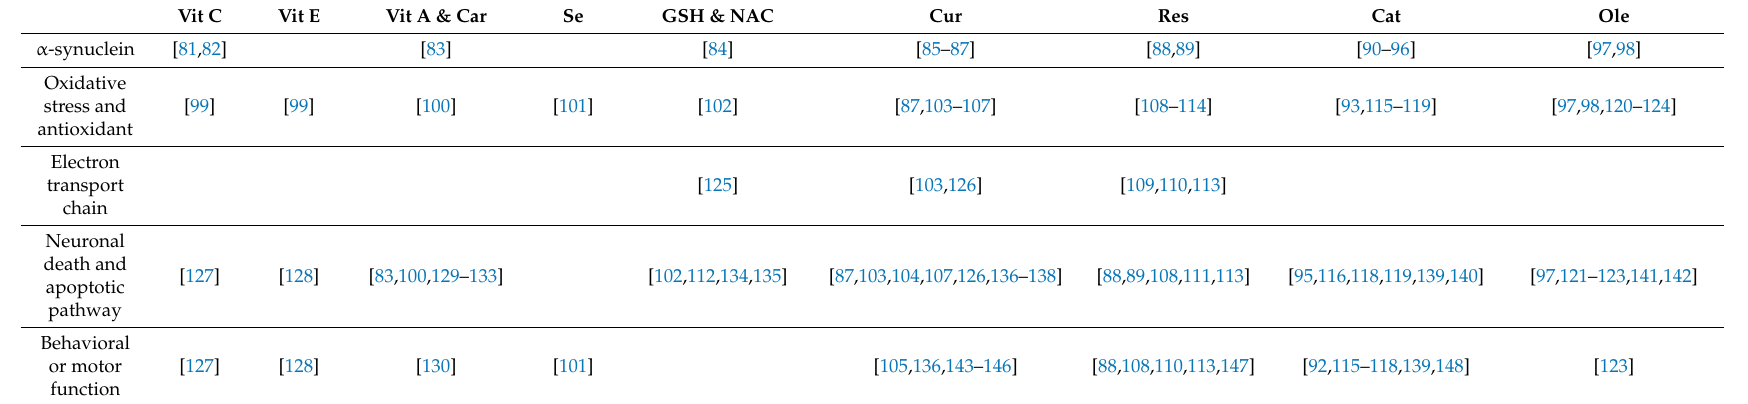
Table 1. List of studies investigating the roles of antioxidant nutrients in PD